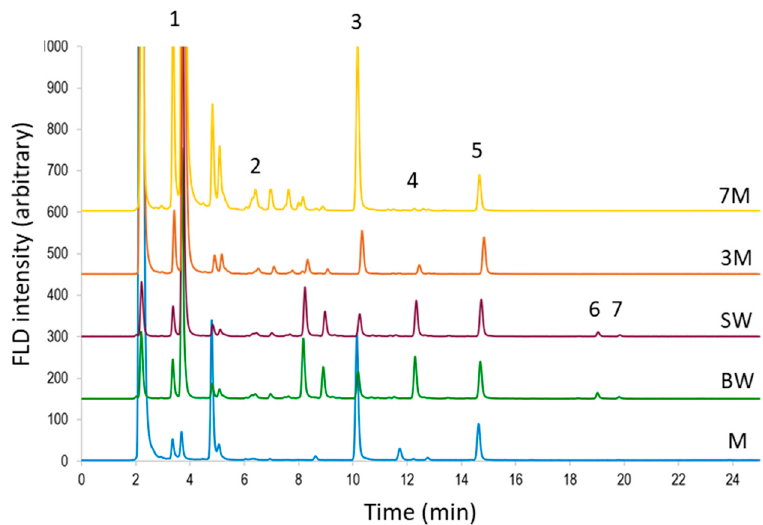
Figure 1. FLD chromatograms of the five types of sample classes from Pinot Noir variety using grapes of D quality. Sample assignment: M = must; BW = base wine; SW = stabilized wine; 3M = sparkling wine of 3 months aging; 7M = sparkling wine of 7 months aging. Peak assignment: 1 = Ethanolamine; 2 = Agmatine; 3 = Lysine; 4 = Cadaverine; 5 = Internal standard; 6 = Tyramine; 7 = Spermidine.